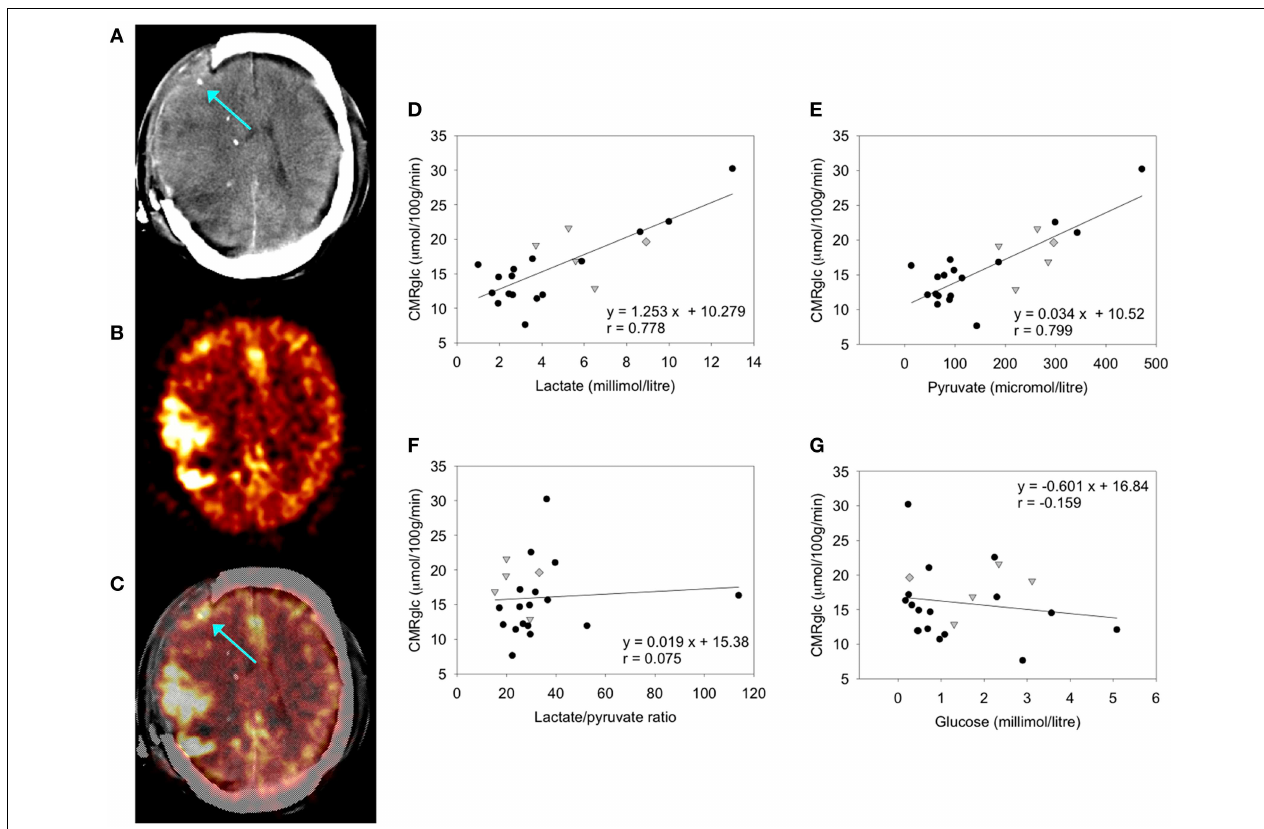
FIGURE 2 | FDG-PET measurement of CMRglc and its relationship to brain microdialysate composition: (A–C) FDG-PET CMRglc map demonstrating relatively high FDG uptake at sites of injury, in contrast to less injured areas of the brain. (A) Computed tomography (CT) scan showing gold tip of microdialysis catheter (indicated by arrow). (B) Co-registered FDG-PET CMRglc map showing high FDG uptake at sites of injury. (C) Overlay of CT and co-registered CMRglc map, showing microdialysis catheter tip location (arrow). (D–F) Graphs illustrating relationships by linear regression (for 22 ROIs in 17 TBI patients) between FDG-PET derived CMRglc and the microdialysis parameters measured during the scan (D) lactate, (E) pyruvate, (F)